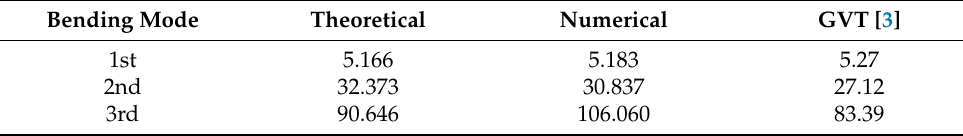
Table 5. Results of the spar’s natural frequencies’ prediction and previous testing campaign.